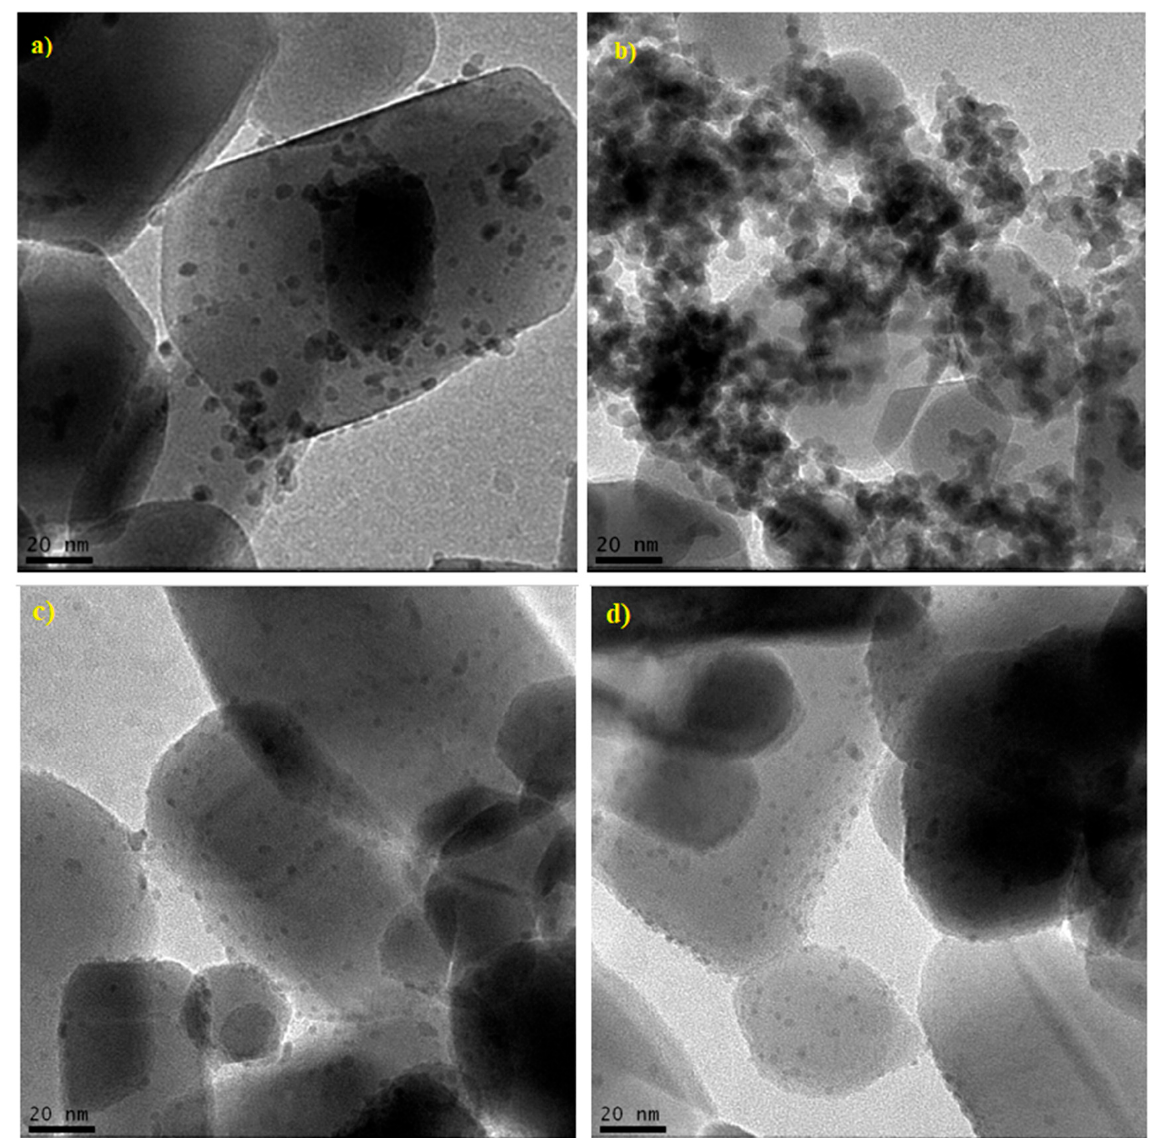
Figure 3. Transmission electron microscopy images of ( a , b ) Sample A and ( c , d ) Sample B. The XPS analysis was used to determine the chemical state of the elements in the samples before and after irradiation, as shown in Figure 5. Figure 5a shows the Zn 2p 3/2 and 2p 1/2 region of Sample B before irradiation, corresponding to 1021.41 eV and 1044.53 eV binding energies, respectively. For the same sample after photocatalytic testing, the binding energies show a slight shift to 1021.50 eV and 1044.62 eV, respectively [24]. The difference of ~23.1 eV between them indicates the presence of Zn in a +2 oxidation state even before or after the irradiation experiments. The peaks located at 335.48 and 340.76 eV are assigned to Pd 3d in its Pd 0 chemical state, with no +2 and +4 oxidation states, respectively. After irradiation, these peaks shifted to 335.14 and 340.38 eV, respectively, and the presence of the Pd +2 species was observed, although most of the Pd existed in oxidation state 0. The XRD (Figure 1a) also confirms that the ZnO structure was preserved after irradiation, showing that the photocatalyst has good stability under reaction